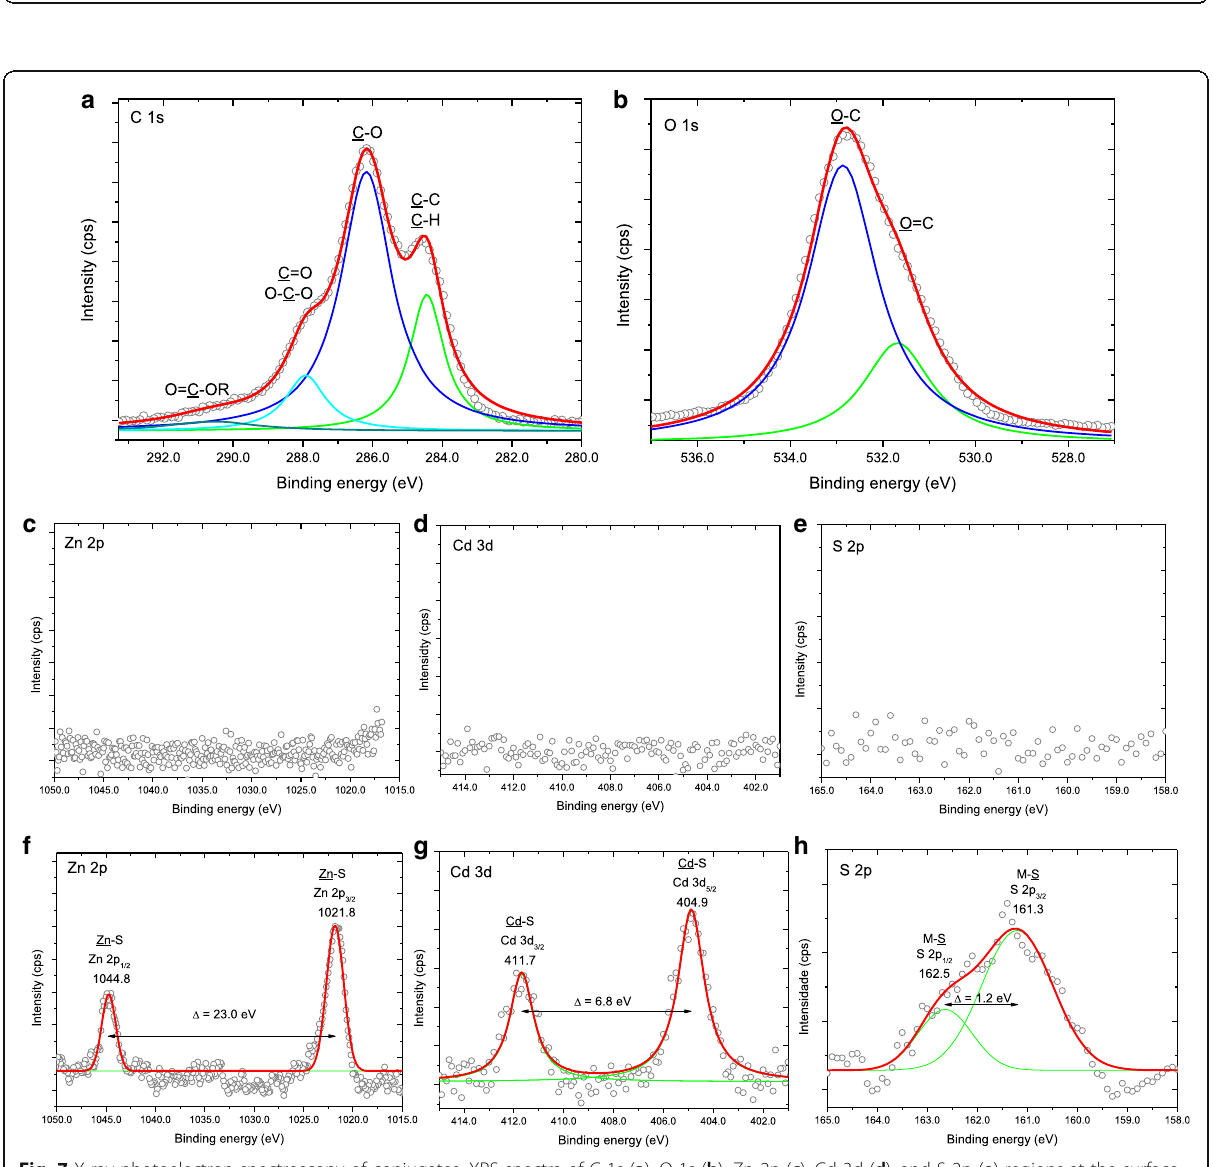
Fig. 7 X-ray photoelectron spectroscopy of conjugates. XPS spectra of C 1s ( a ), O 1s ( b ), Zn 2p ( c ), Cd 3d ( d ), and S 2p ( e ) regions at the surface of Zn 0.50 Cd 0.50 S ternary system and XPS spectra of Zn 2p ( f ), Cd 3d ( g ), and S 2p ( h ) regions after